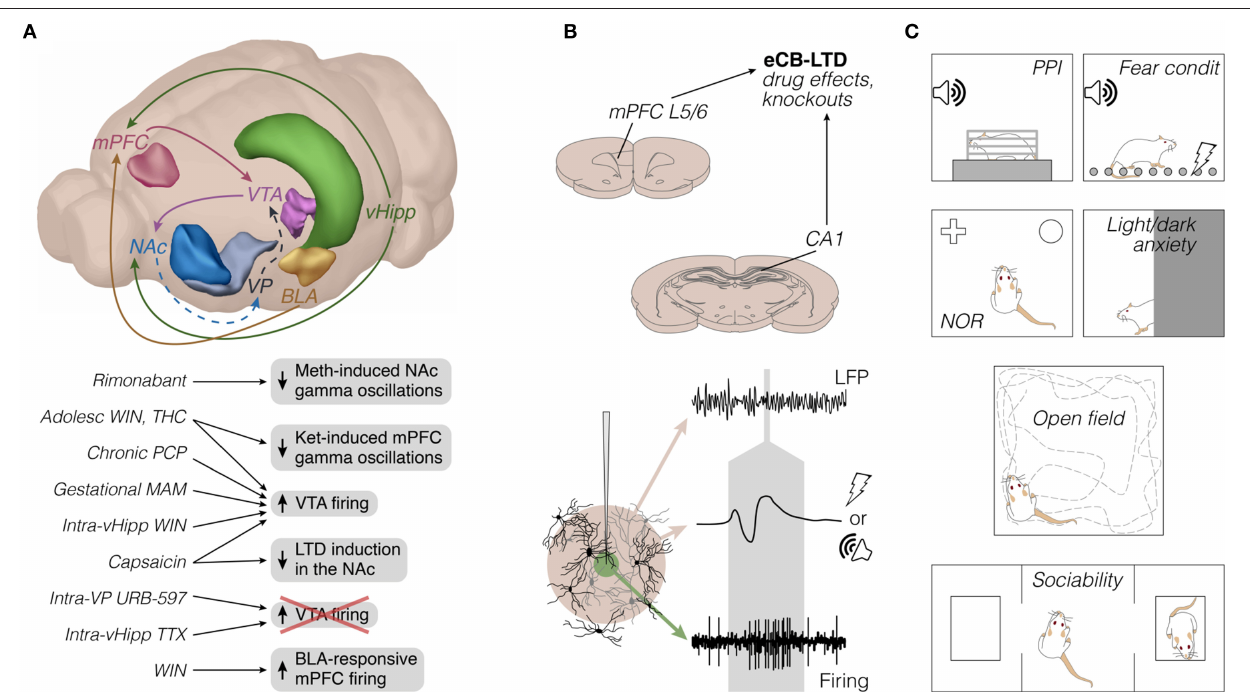
FIGURE 1 | Rodent electrophysiology literature on cannabinoids and vanilloids in schizophrenia-relevant circuits: emphasis on methods. (A) Top: Frequently studied brain sites and axonal pathways. To our knowledge, projections like VTA-mPFC, mPFC-NAc, and mPFC-BLA have not yet been directly examined, and are therefore omitted for simplicity. Dashed lines represent GABAergic pathways. Only the left hemisphere is represented (brain sites adapted from the Brain Explorer, Allen Institute). Bottom: Main electrophysiological findings, mostly from in vivo experiments (see also Figures 2 , 3 ). (B) Top: representative brain sites and manipulations of in vitro studies (coronal sections adapted from Paxinos and Watson, 2007; see also Figure 3 ). Bottom: illustrative recording probe, e.g., glass or steel microelectrode, from which LFP (beige area) and single-unit firing (green area) can be recorded upon adequate filtering, amplification, and digitization. The middle voltage trace represents a field potential response to afferent electrical or auditory stimulation, both of which present in the reviewed literature. The gray area roughly indicates the timescale between types of signal. (C) Prevalent behavioral tests in the reviewed literature, most of them performed separately from electrophysiological experiments. Adolesc, adolescent; BLA, basolateral amygdala; condit, conditioning; eCB-LTD, endocannabinoid long-term depression; Ket, ketamine; L5/6, layers 5/6; LFP, local field potentials; MAM, methylazoxymethanol acetate; Meth, methamphetamine; mPFC, medial prefrontal cortex; NAc, nucleus accumbens; NOR, novel